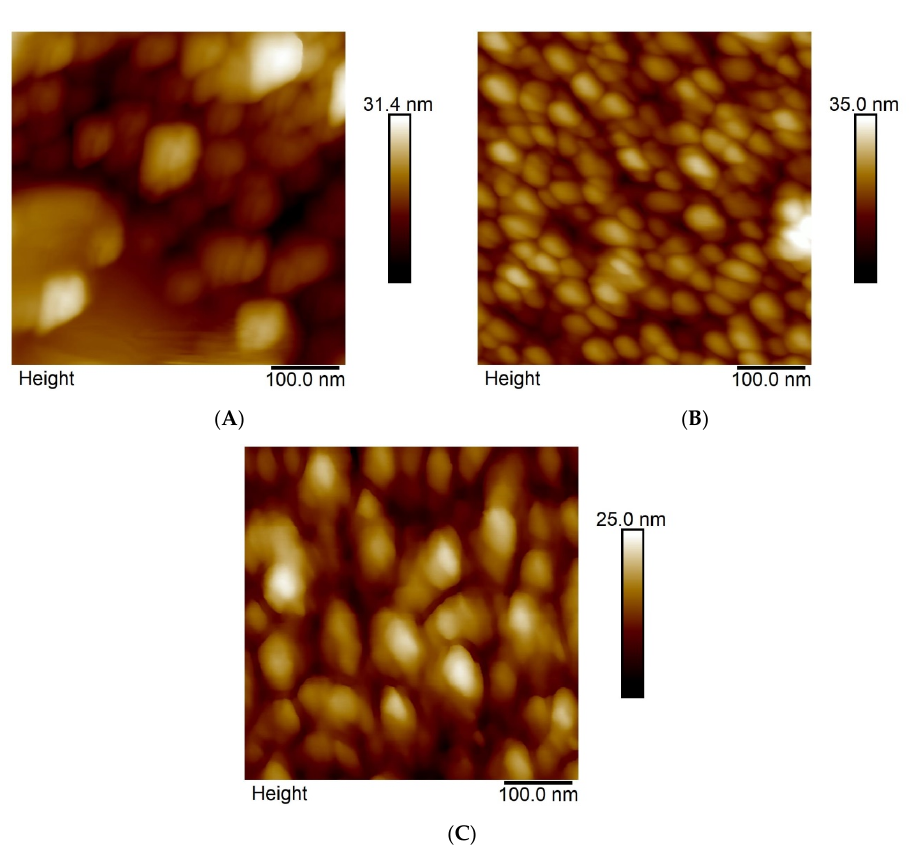
Figure 2. Atomic force microscopy (AFM) images (500 × 500 nm 2 ) of the ( A ) MIP, ( B ) extracted MIP, and ( C ) NIP film deposited on Au film-coated glass slides by electropolymerization under potentiodynamic conditions.